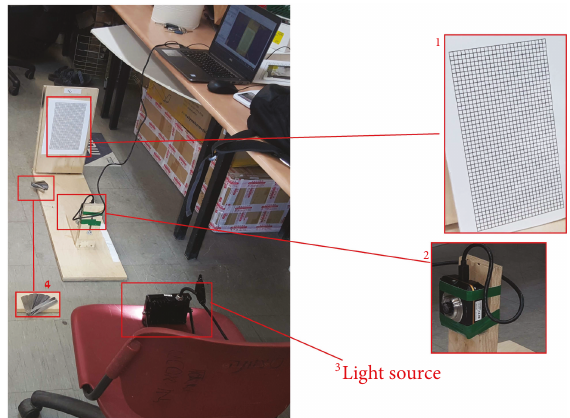
Figure 13: The practical setting of the next experiments that proves the accuracy level. The setting is divided into 4 main components: 1 is a dynamic plate that has the surface (plate) to be mapped which can move toward front or back. 2 is a stabilized stand that holds the camera. 3 is a light source to overcome the problem of the pixel snapping. 4 is a submillimeter spacer that we can measure the movement of the plate (1), so we have a reference for the actual movement.